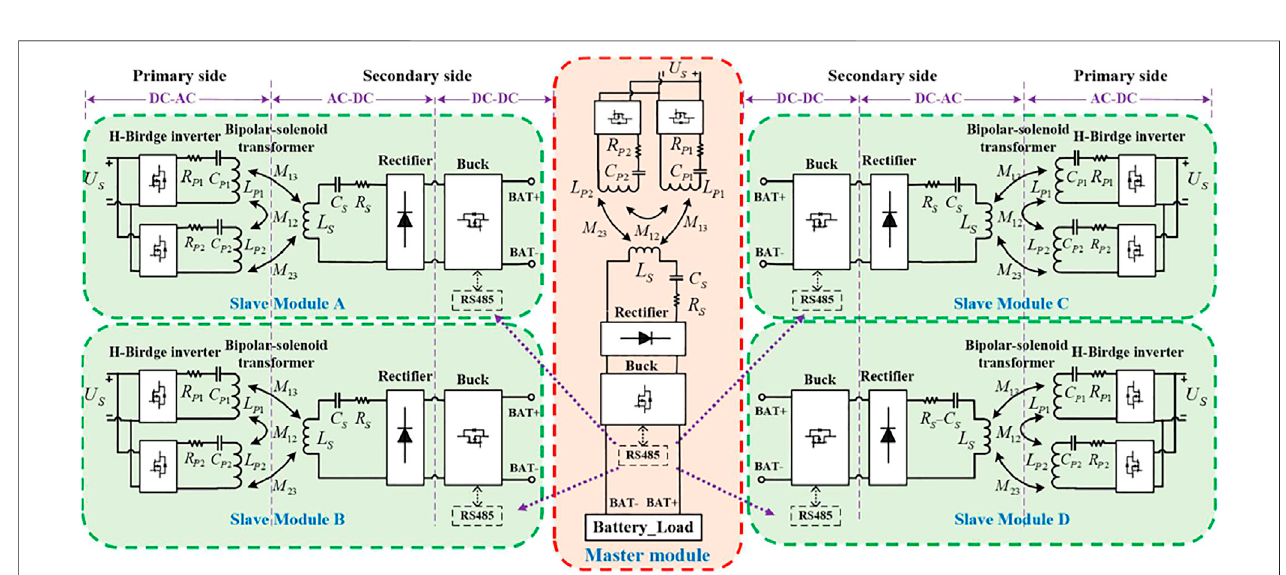
FIGURE 2 | Modular WPT system